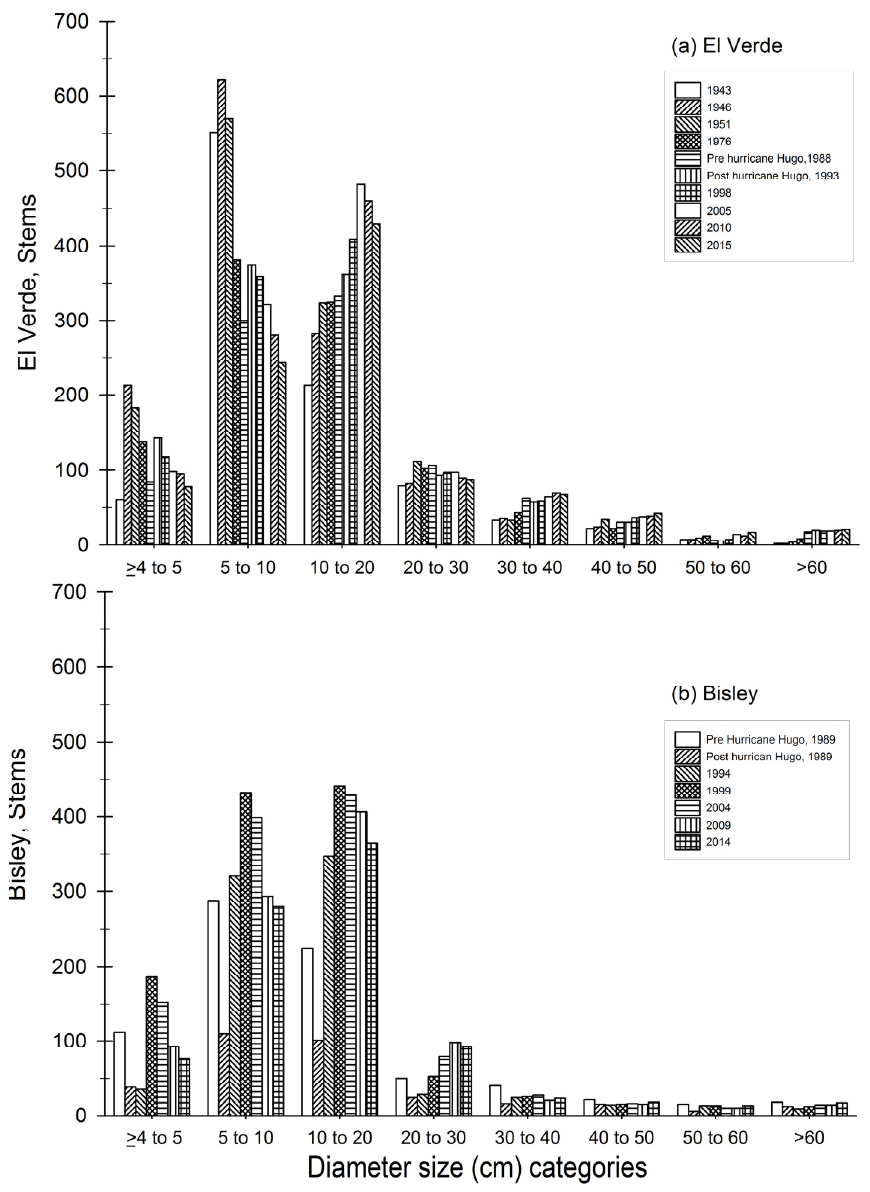
Figure 5. Diameter size category distribution for each census year for El Verde ( a ) top panel and ( b ) Bisley (bottom panel). Each bar represents a census year.